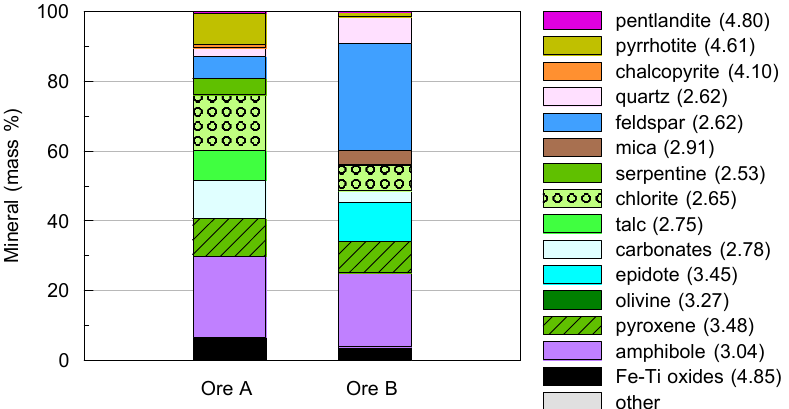
Figure 5. Bulk mineralogy of the individual density fractions for the ore A ( A ) and B ( B ) overflow, and ore A ( C ) and B ( D ) underflows. The change in quartz + feldspar content with density is shown with dotted lines, as an example of gangue separation. 4.2. Nickel Deportment